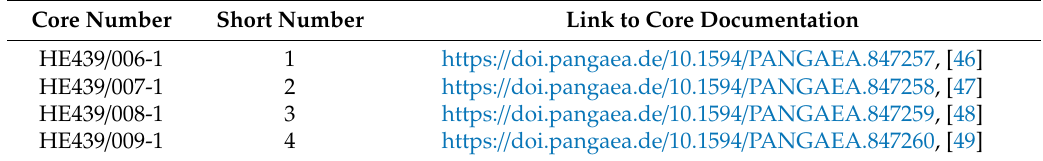
Table 4. Links to the database with detailed core descriptions and